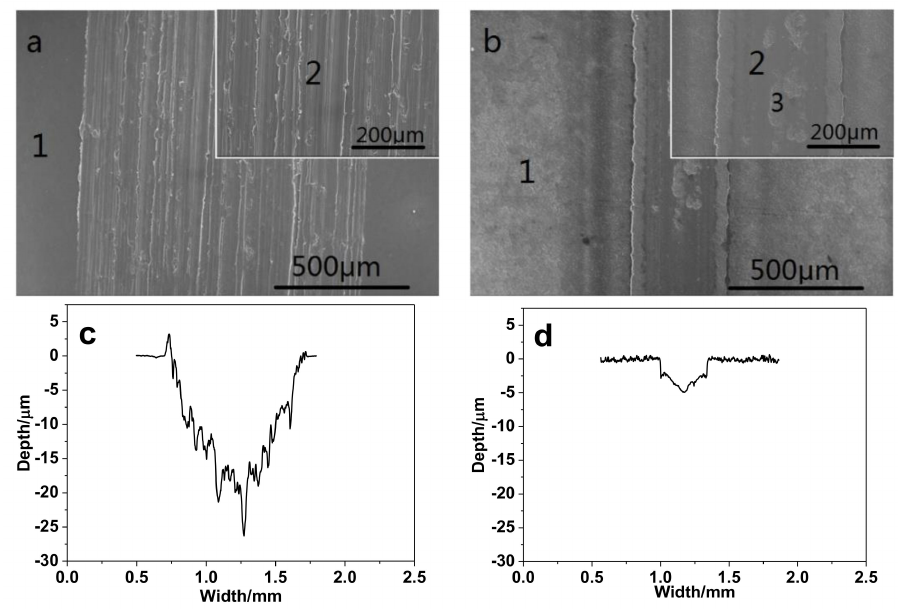
Figure 6. SEM image of the wear track morphology and profiles of various samples after OCP tribocorrosion test. ( a,c ) Untreated and ( b,d ) thermally oxidized samples.